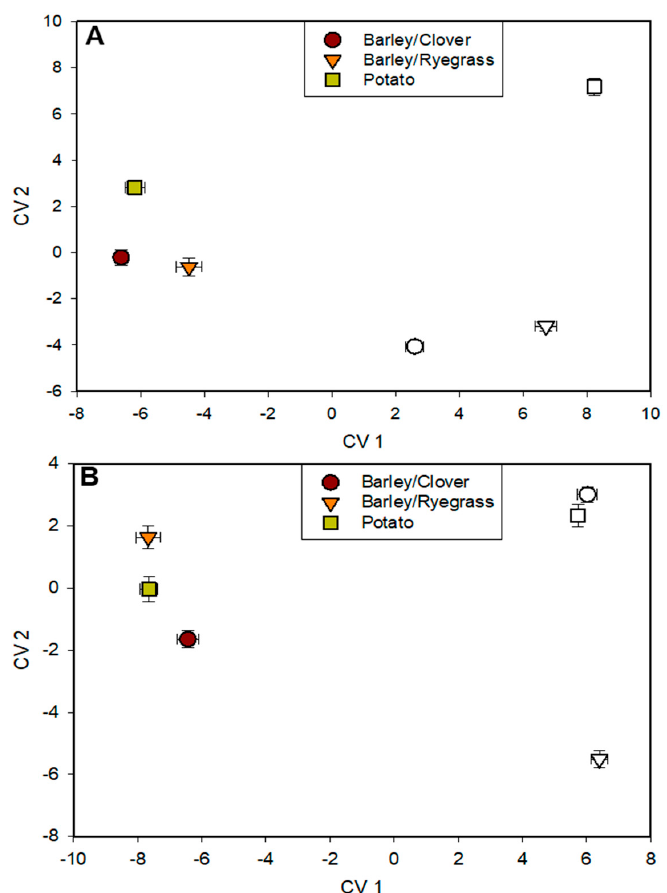
Figure 3. Effects of rotation crops on soil fatty acid methyl ester (FAME) profiles as represented by canonical variates (CV) 1 and 2 from canonical variates analysis from soils sampled prior to (open symbols) and one month after incorporation (filled symbols) of rotation crop residues in the Spring of year 2 at ( A ) location 1 (Central Maine) and ( B ) location 2 (Northern Maine).